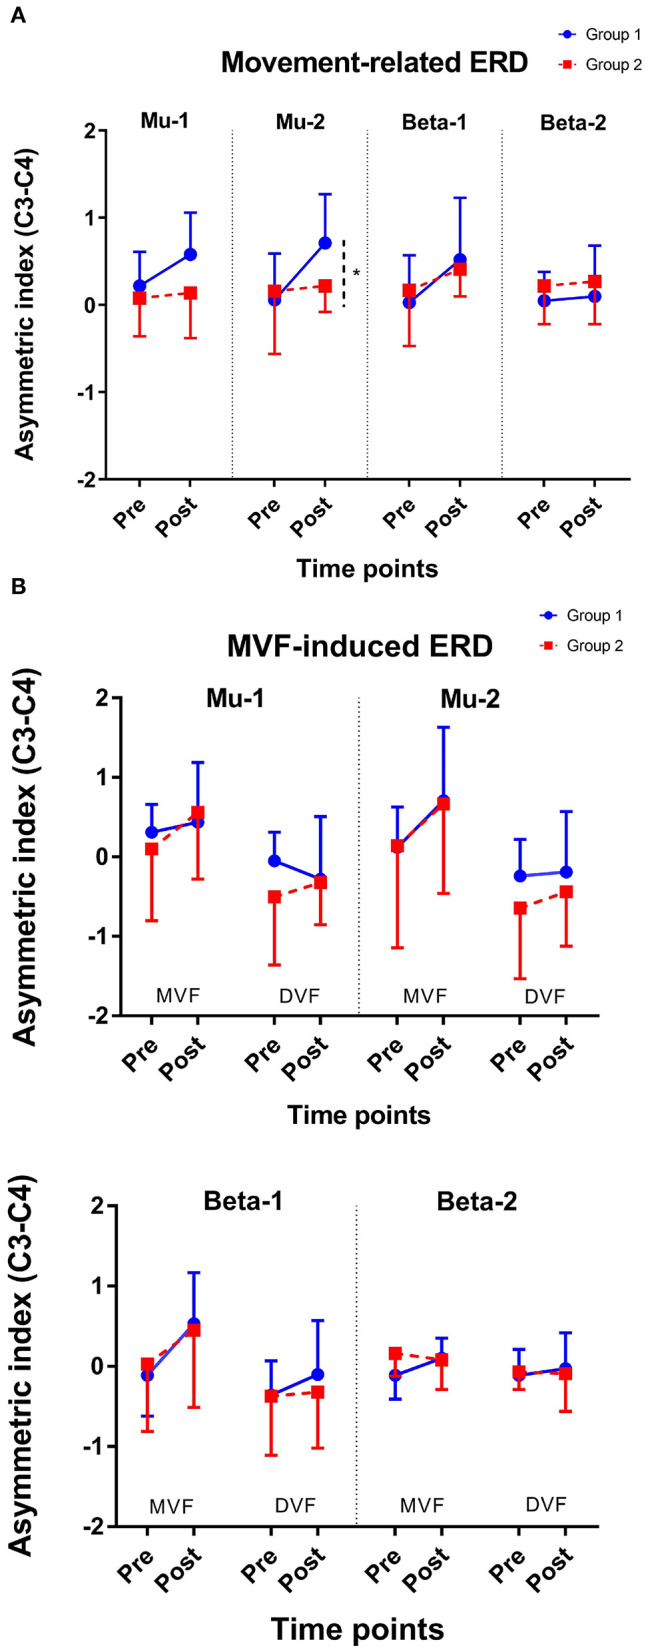
Change of asymmetric index. (A) Movement-related ERD and (B) MVF-induced ERD. *represents p for the interaction effect < 0.05; Error bars represent the standard deviation.